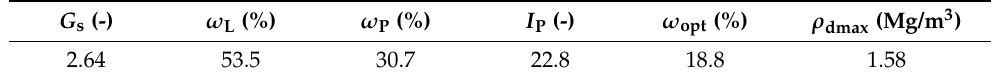
Figure 2. Compaction curve of GRS from standard Proctor test. Table 1. Basic physical properties of granite residual soil.